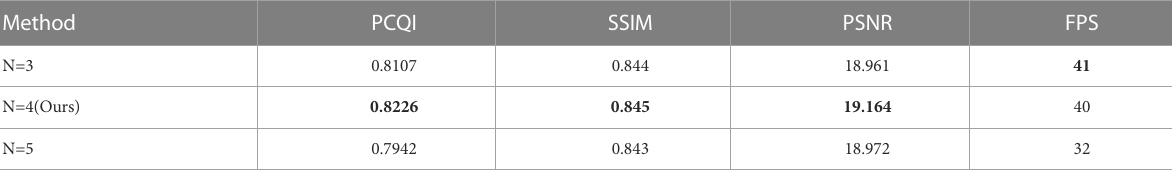
TABLE 8 PCQI, SSIM, PSNR, and FPS comparison on the UIEB dataset using different RCAB numbers.